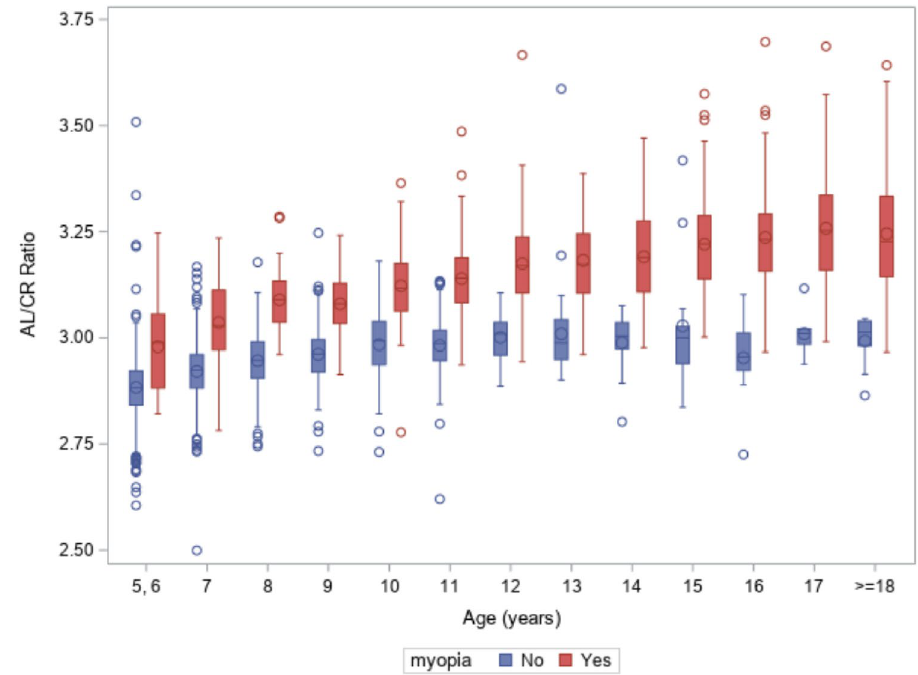
Figure 2. Boxplots for distribution of AL/CR by myopia status and age group of students.